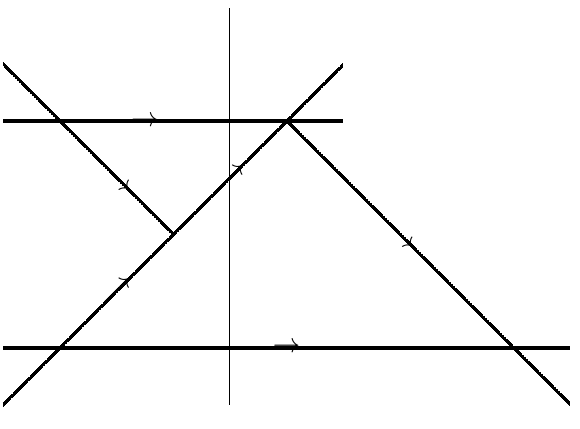
Figure 4 . A reduced diagram with no oriented closed loop and the arrows drawn so that they always point to the right. Therefore the energies (cid:13)ow from left to right along all the propagators. The ordering of the vertices can sometimes be ambiguous, e.g. any one of the two left-most vertices could be drawn to the left of the other.